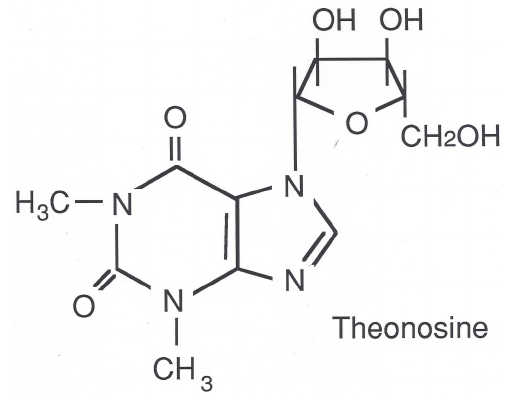
Figure 2. Theonosine structure.